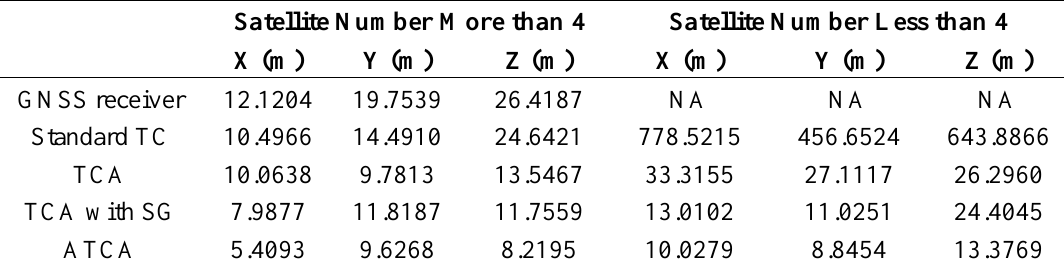
Table 2. RMS position error